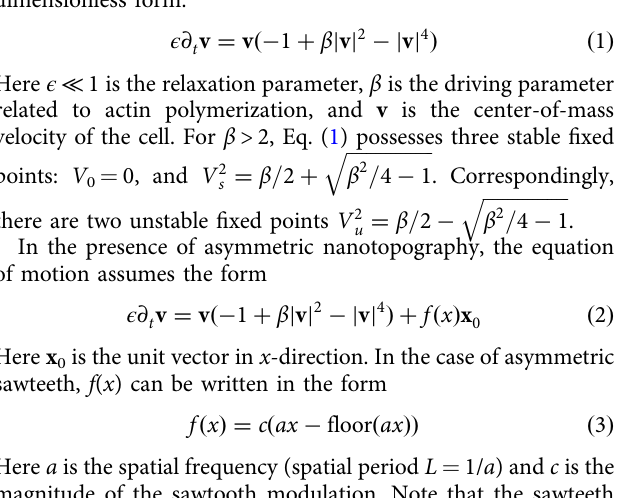
direction of stable simulation trajectories corresponds to the preferential guidance direction of cells on asymmetric sawteeth.